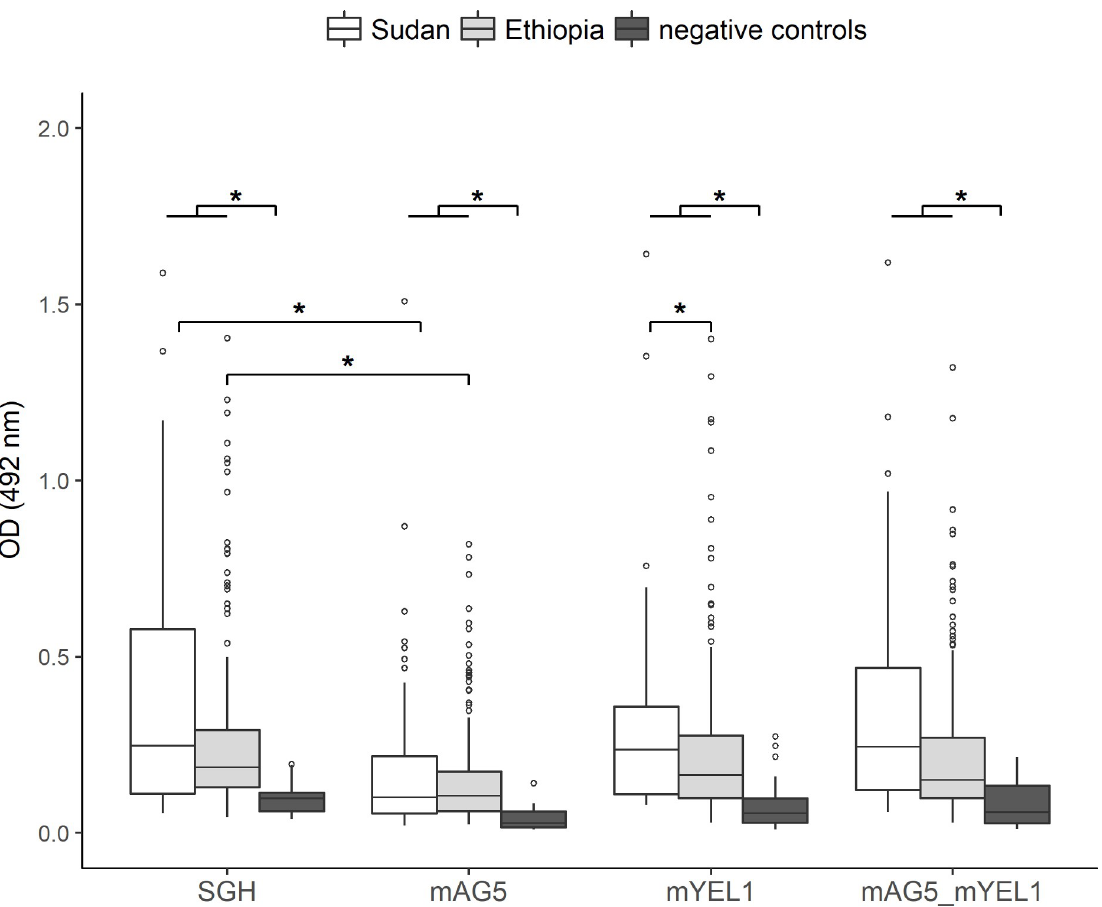
Fig 4. Antibody response against mAG5, mYEL1, their combination, and SGH. Plotted optical densities obtained from ELISA with serum samples from Sudan (50), Ethiopia (235), and 18 negative control samples. Results are shown in box plot graphs where boxes display the 25 th -75 th percentiles of OD values and median value; vertical lines represent minimum to maximum values and dots the outliers. Asterisks notes statistical significance of p < 0.05.